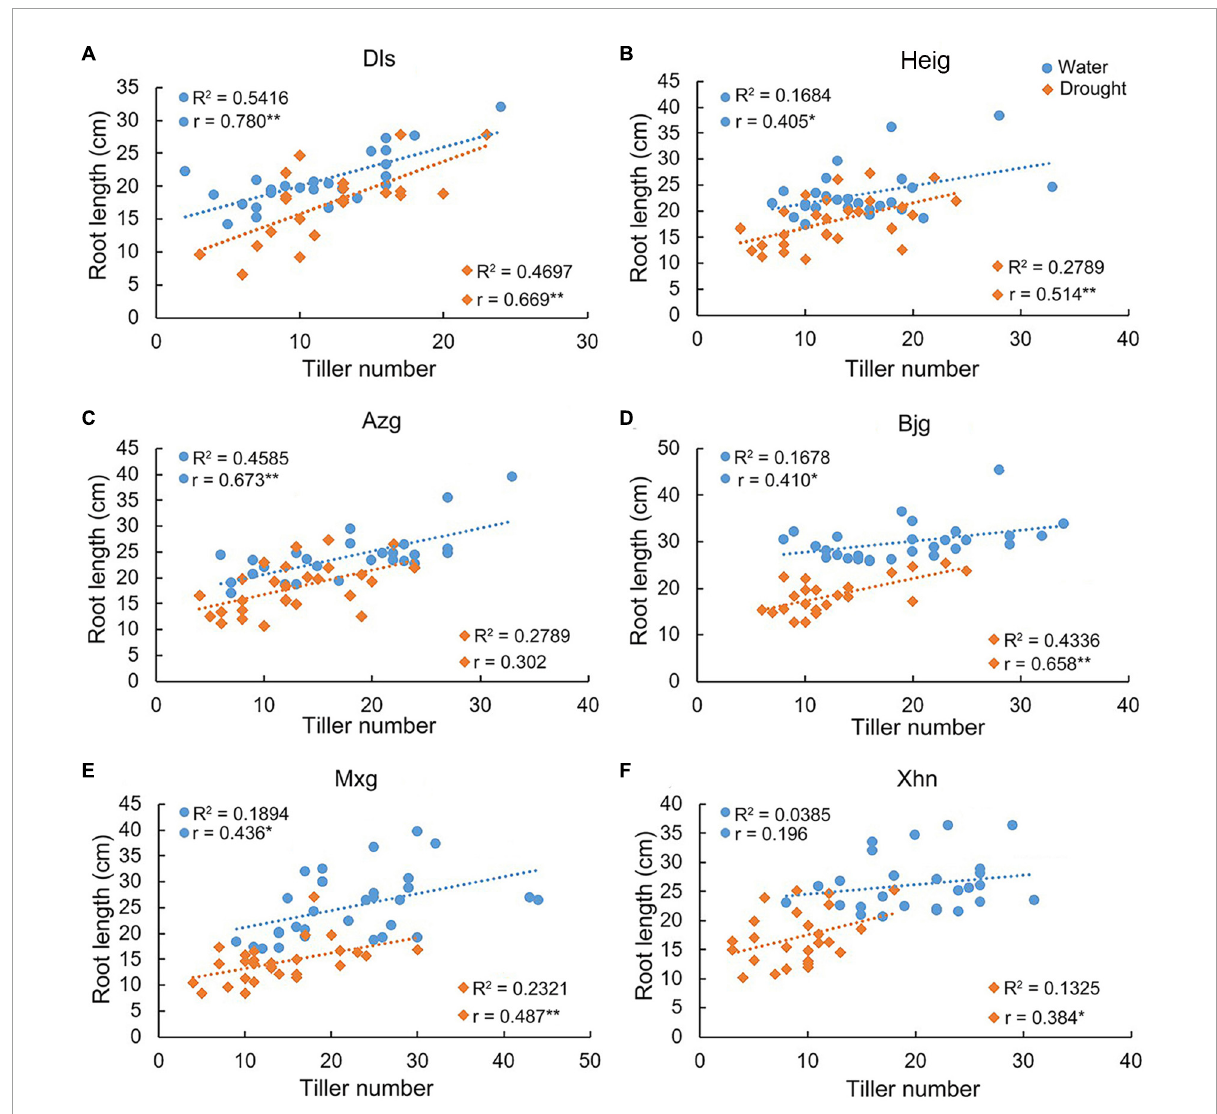
FIGURE2 Correlations between tiller numbers and root lengths in different rice varieties. The correlation between root lengths and tiller numbers in six rice varieties shown in Figures 1A–L were analyzed by using SPSS software (A–F) . R 2 , determination coefficient; r, Pearson’s correlation coefficient; r > 0, positive correlation; * P < 0.05, ** P < 0.01 (SPSS analysis). Water, rice seedlings grown under irrigation condition; Drought, rice seedlings grown under drought condition; Dls, Da Leng Shui; Heig, Hei Gu; Azg, Ai Zhe Gu; Bjg, Ban Jiu Gu; Mxg, Ma Xian Gu; Xhn, Xiao Hua